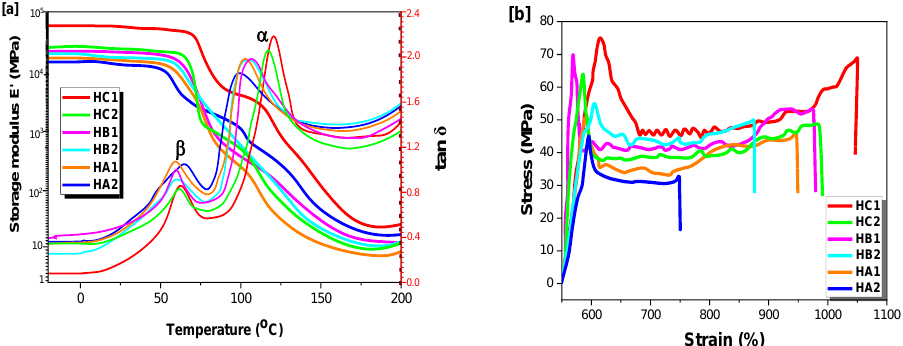
Figure 9. ( a ) Dynamic mechanical thermal analysis (DMTA) of the poly(ether-ester)s, showing the evolution of the storage modulus E’ and tan δ with temperature. ( b ) Tensile testing curves for the poly(ether-ester)s. Table 3. Tensile properties of poly(ether-ester)s and compared with other polymers.